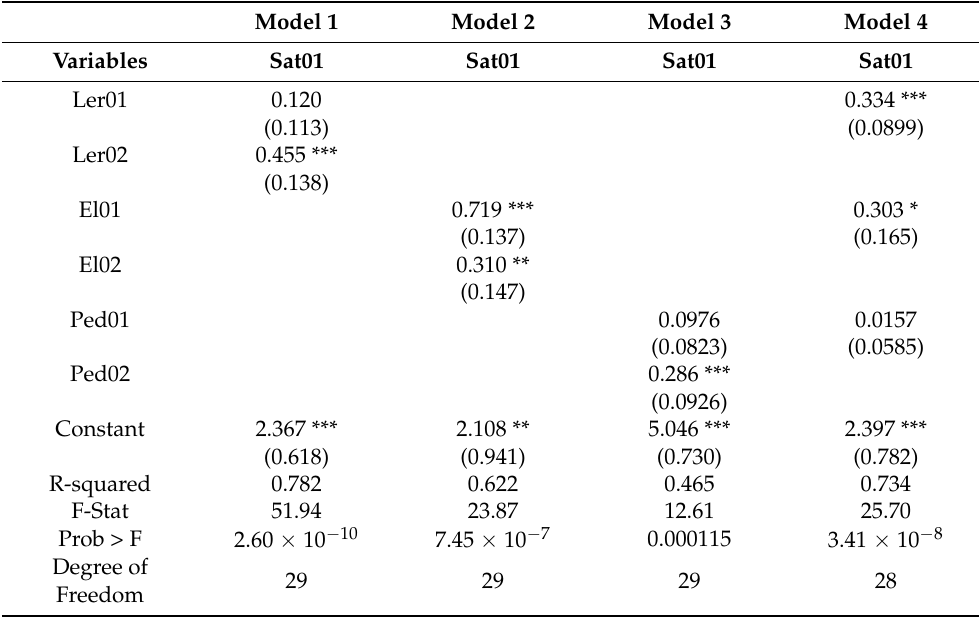
Table 22. Test results for the relationship between overall satisfaction and the learning outcomes (Ler), e-learning process (El), and pedagogical practices (Ped) dimensions. Model 1 Model 2 Model 3 Model 4 Variables Sat01 Sat01 Sat01 Sat01 Ler01 0.120 0.334 *** (0.113) (0.0899) Ler02 0.455 *** (0.138) El01 0.719 *** 0.303 * (0.137) (0.165) El02 0.310 ** (0.147) Ped01 0.0976 0.0157 (0.0823) (0.0585) Ped02 0.286 *** (0.0926) Constant 2.367 *** 2.108 ** 5.046 *** (0.618) (0.941) (0.730) (0.782) R-squared 0.782 0.622 0.465 0.734 F-Stat 51.94 23.87 25.70 Prob > F 2.60 × 10 − 10 0.000115 Degree of 29 29 Freedom